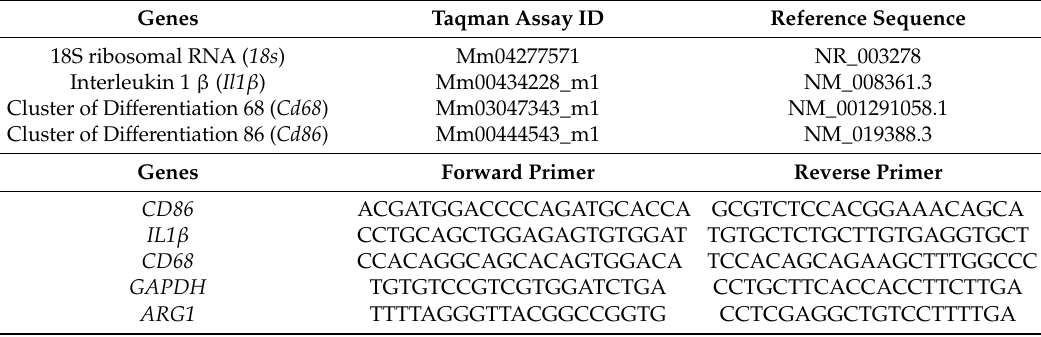
Table 1. List of Gene transcript TaqMan®Probes \ Primers used in the study. Genes Taqman Assay ID Reference